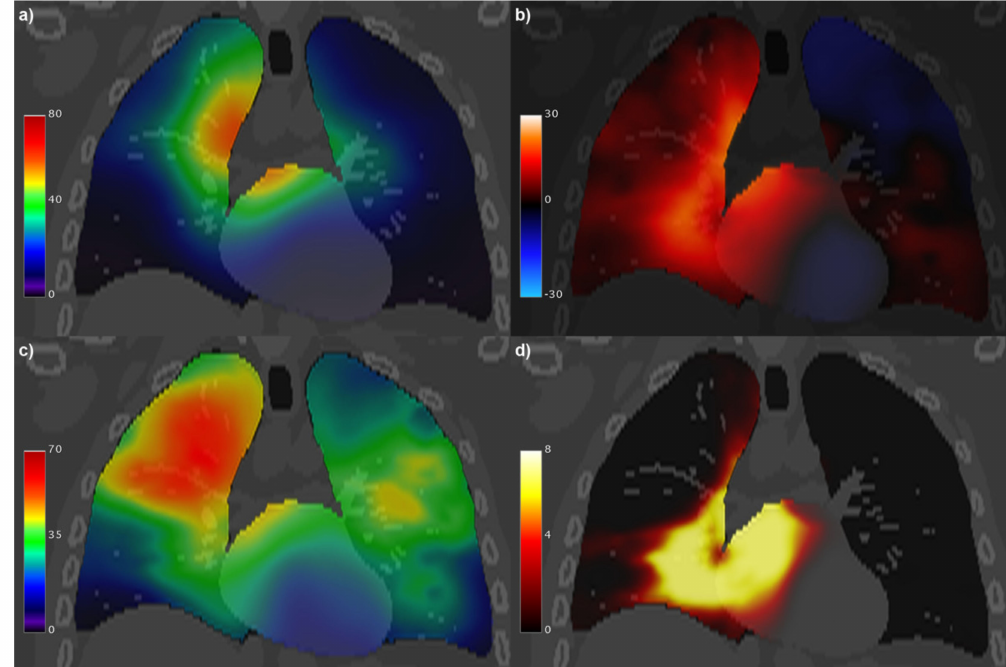
Figure 10. Coronal view of the XCAT computed tomography fused with: ( a ) the voxel-wise mean ( µ ) of the biologically effective dose (BED, in Gy) maps; ( b ) generalized linear model coefficient (in kGy − 1 ) associated with BED for the develop- ment of radiation pneumonitis; ( c ) the voxel-wise standard deviation ( σ ) of BED maps (in Gy); ( d ) significance of the BED coefficient, expressed as − log p